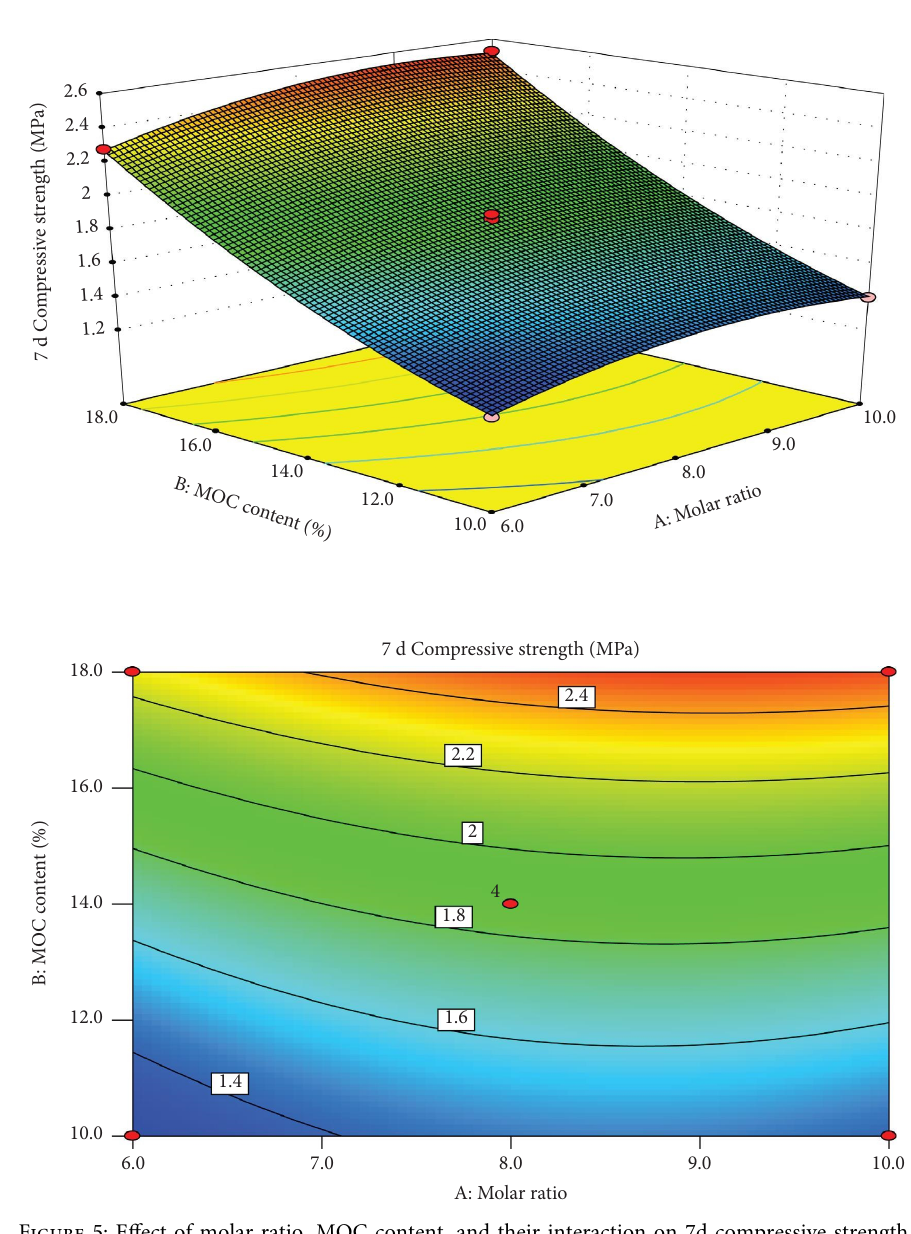
Figure 5: Efect of molar ratio, MOC content, and their interaction on 7d compressive